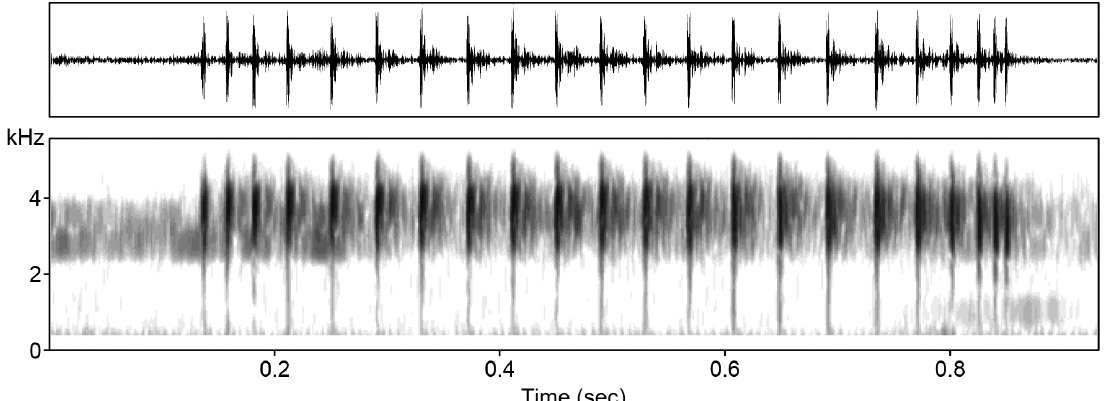
Figure 9. Wave form (above) and spectrogram (below) of an advertisement call from Choerophryne multisyllaba sp. n. consisting of 22 notes.